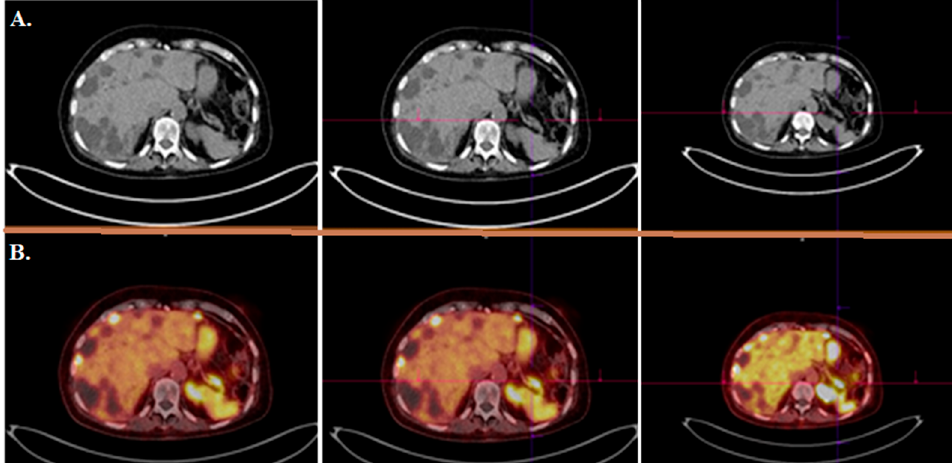
Figure 6. [ 64 Cu]Cu-DOTA-TOC PET-CT: A 76-year-old gentlewoman with a history of resected neuro endocrine tumor of the appendix 10 years ago, with recurrence at multiple bilobar multisegmental liver metastases (image B ); the primary tumor was detected as a suspicious lesion in the tail of the atrophic pancreas (image A ); Ki67 9% .